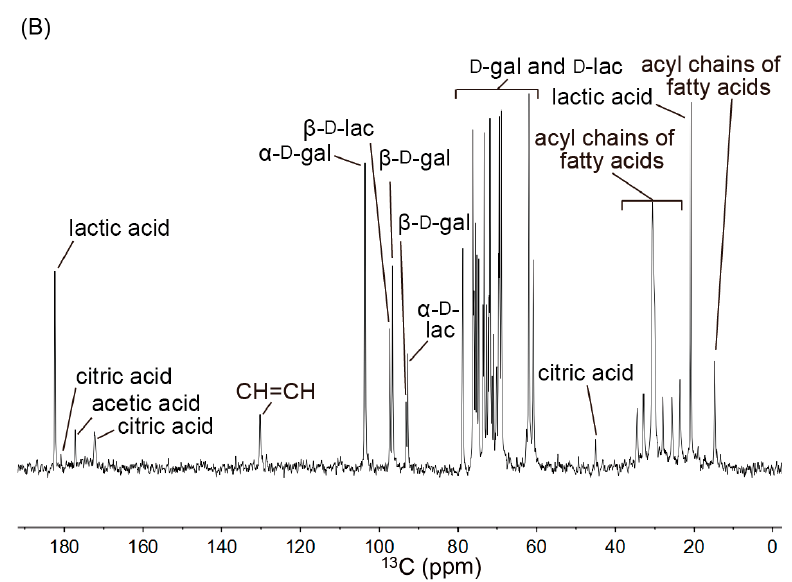
Figure 1. ( A ) The 1 H NMR spectrum of yogurt. ( B ) The 13 C NMR spectrum of yogurt. Gal and lac are abbreviations for galactose and lactose, respectively. Table 1. Assignment of 1 H and 13 C signals of compounds in yogurt.